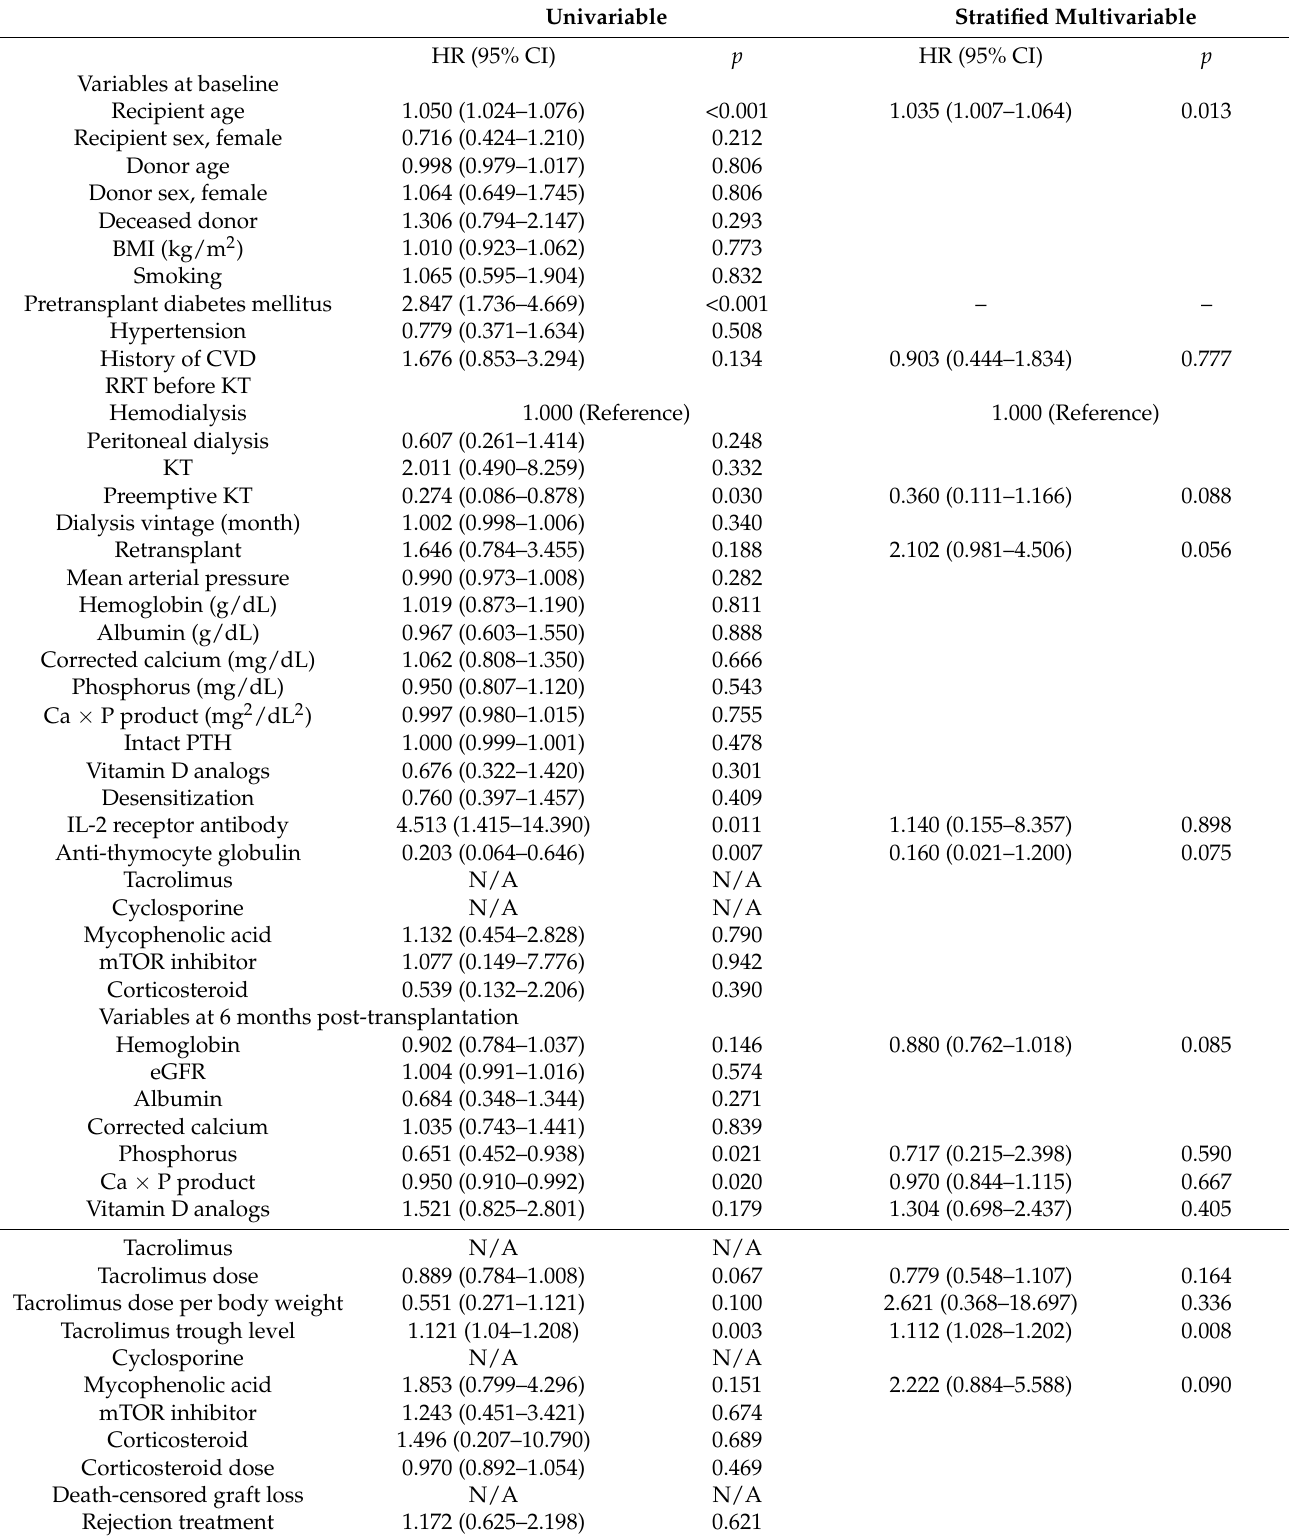
Table 3. Risk factors for incident fractures of the kidney transplant